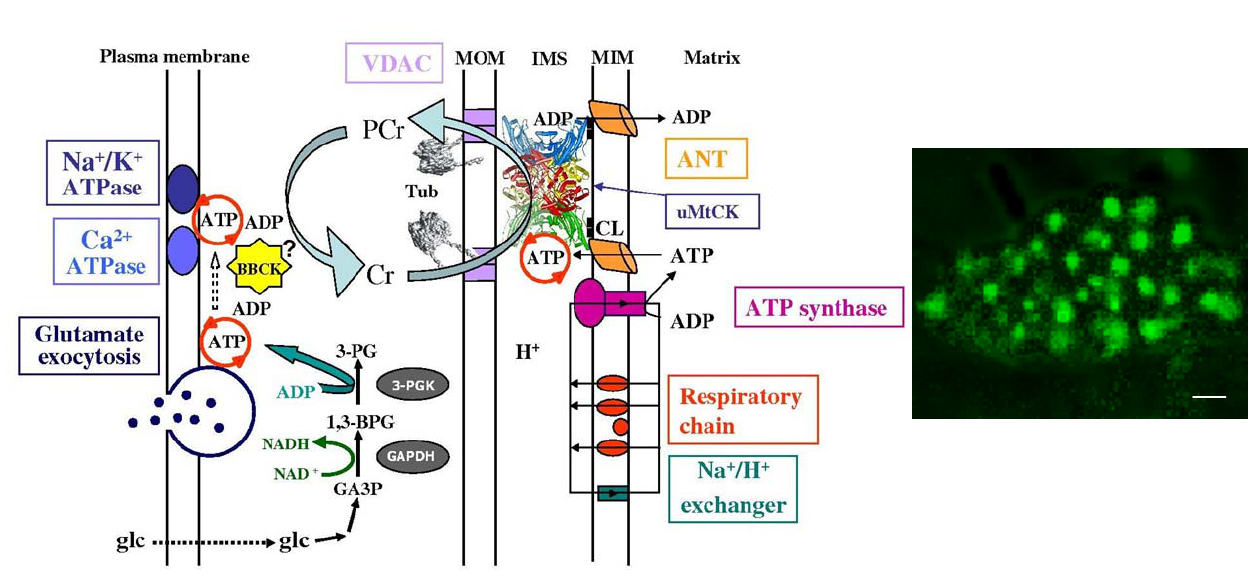
Figure 5. Energetics of brain synaptosomes. Sites of ATP production (mitochondrial matrix) and sites of ATP consumption (ion transport across the plasma membrane and vesicle trafficking for neurotransmitter uptake and release, e.g. glutamate) are linked by an energy transfer pathway represented by the phosphocreatine/creatine kinase system. uMtCK bound to mitochondrial inner membrane (MIM) via cardiolipin (black squares). ATP consumed by the energy consuming reactions is reproduced locally by BBCK from PCr. GA3P, glyceraldehyde-3-phosphate; 1,3-BPG, 1,3 biphosphoglycerate; 3-PG, 3- phosphoglycerate; GAPDH, glycerate-3-phosphate-deshydrogenase; 3-PGK, 3- phosphoglycerate kinase; VDAC, voltage dependant anion channel; MOM, mitochondrial outer membrane; uMtCK, ubiquitous mitochondrial creatine kinase; Tub – αβ heterodimer of tubulin interacting with the VDAC channels and limiting its permeability for adenine nucleotides. Right panel shows the confocal image of isolated rat synaptosomes Mitochondria were labelled by pre-incubation with mitochondrial inner membrane